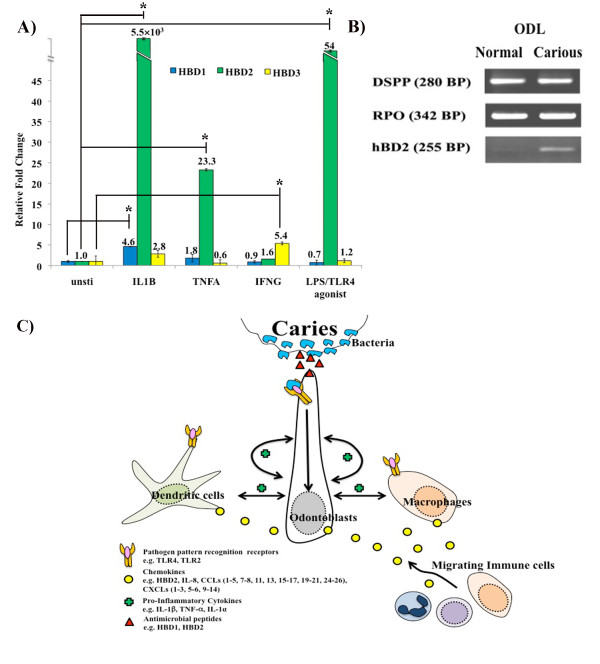
Innate immunity in the odontoblast layer (ODL). The effect of IL-1β/IL1B, TNF-α/TNFA, IFNγ/IFNG, and LPS on antimicrobial peptide regulation determined by real-time quantitative PCR (A). The effect of caries on HBD2 mRNA expression was detected by semi-quantitative PCR (B). IL-1β, TNF-α, and LPS amplify HBD2 transcription in odontoblast-like cells in vitro. Consistently, caries increase expression of HBD2 mRNA in cells of ODL in vivo. Values are reported as relative fold change in mRNA transcription of unstimulated versus stimulated samples. The data represent means and standard errors from triplicate wells of one experiment and are representative of at least three independent experiments. Asterisks indicate statistically significant changes, with P < 0.05. A diagram illustrates the proposed caries-induced cellular interactions among cells in ODL through pro-inflammatory cytokines and chemokines (C). Bacterial components from caries activate cytokine/chemokine release from odontoblasts, dendritic cells, and/or macrophages via toll-like receptors (TLRs). Proinflammatory cytokines released from these cells act as autocrine and paracrine signals to amplify cytokine responses including antimicrobial peptide, cytokine, and chemokine production. The release of chemokines creates a migration gradient for immune cells to ODL while antimicrobial peptides reduce bacterial load.